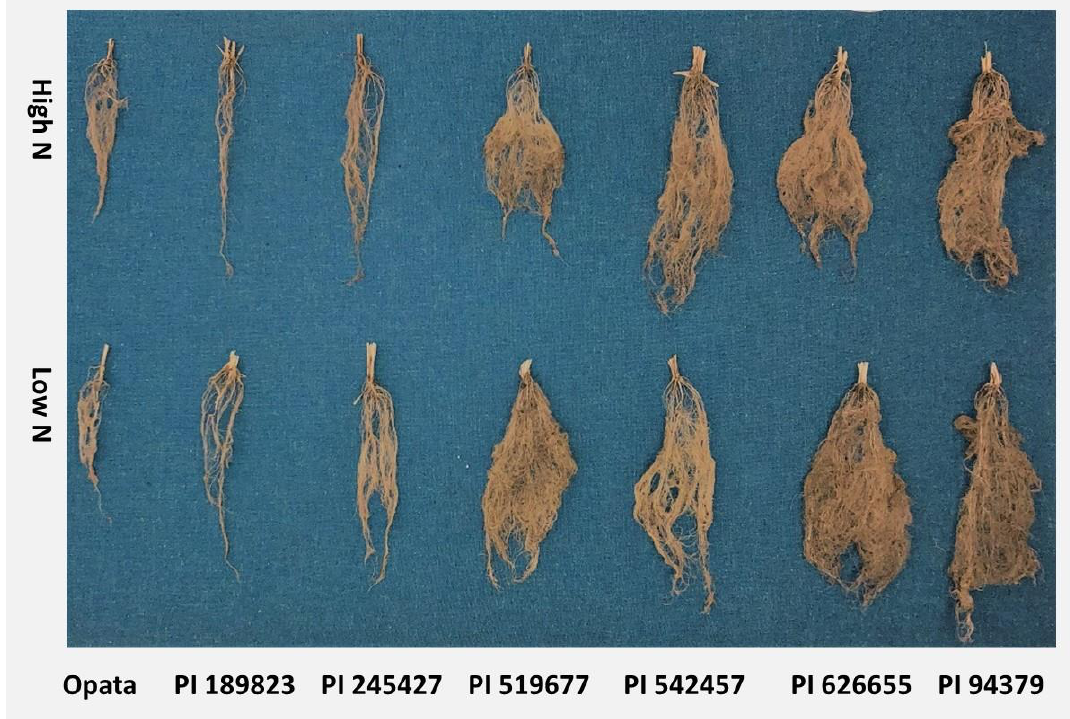
Figure 7. Representative root structure for each line in each N treatment from the maturity assay.